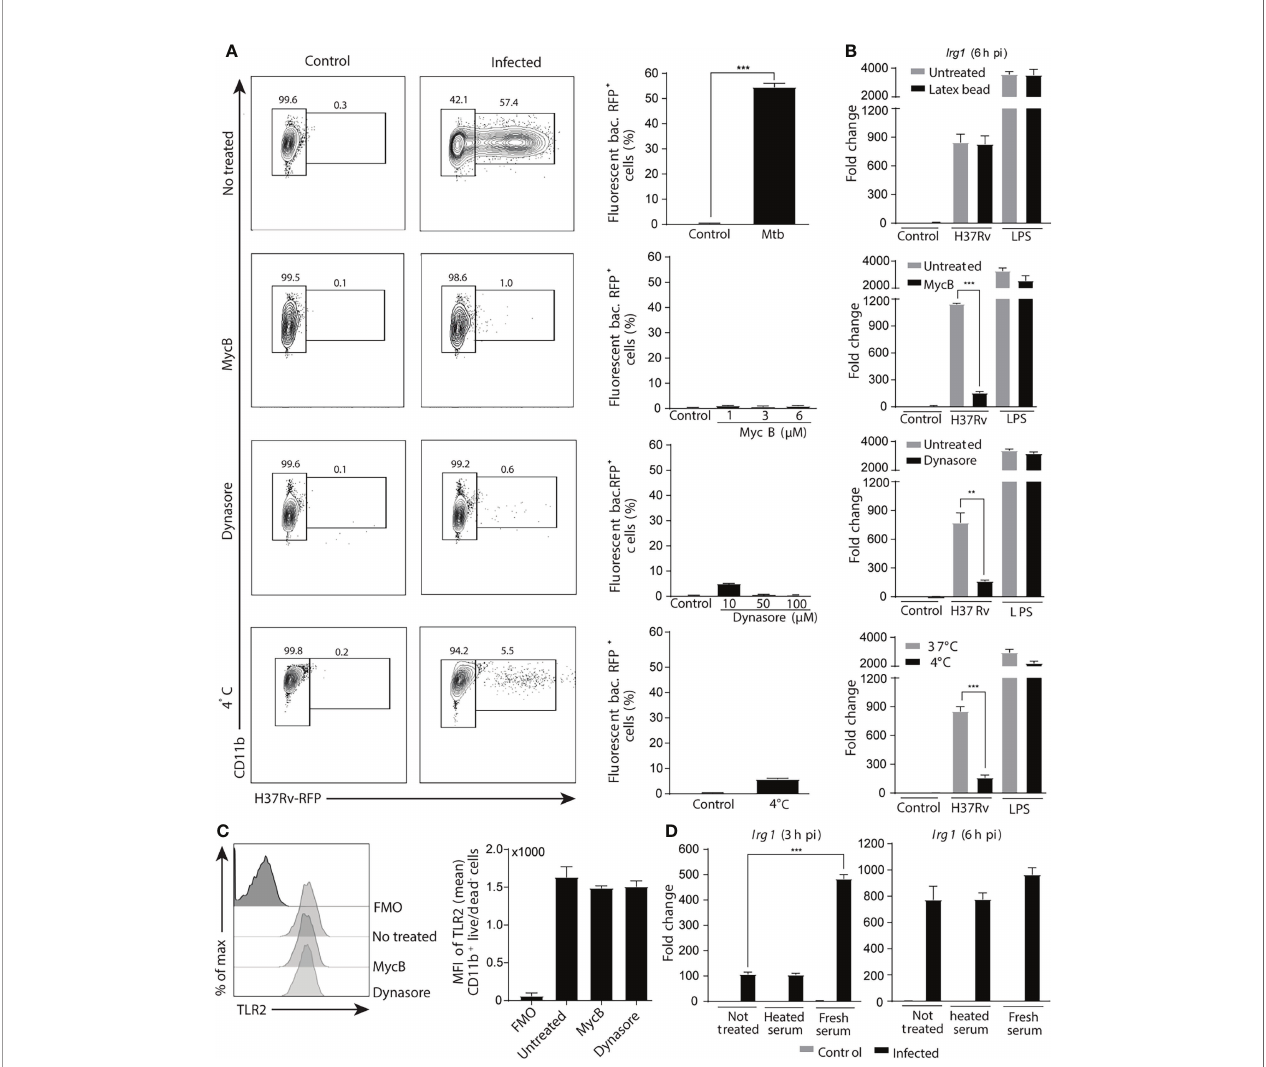
FIGURE 3 | Phagocytosis of Mtb is crucial for the induction of Irg1 gene expression. (A – C) Macrophages were pretreated with the phagocytosis inhibitors Mycalolide B (MycB; 1 µM, 3 µM or 6 µM) or Dynasore (10 µM, 50 µM or 100 µM) for 1 h and then infected with H37Rv-RFP or stimulated with LPS (10 ng/ml) as indicated. (A) Phagocytosis was determined by fl ow cytometric analysis at 6 h after H37Rv-RFP Mtb exposure (MOI of 1). FACS plot (left panel) and summary data (right planel) are shown. (B) Irg1 expression was evaluated in BL/6 BMDMs exposed to latex beads (0.025%) (upper graph) or to H37Rv treated or not with MycB and Dynasore as well as in cultures left at 4 0 C. (C) TLR-2 protein expression by Mtb-infected macrophages following MycB and Dynasore treatment assessed by fl ow cytometry. (D) Irg1 mRNA levels were determined in BMDMs exposed to H37Rv opsonized or not with fresh or heat-inactivated naïve mouse sera at 3 h and 6 h p.i. Statistically signi fi cant differences are indicated as follows: **p < 0.01 and ***p < 0.001. Data are representative of two separate